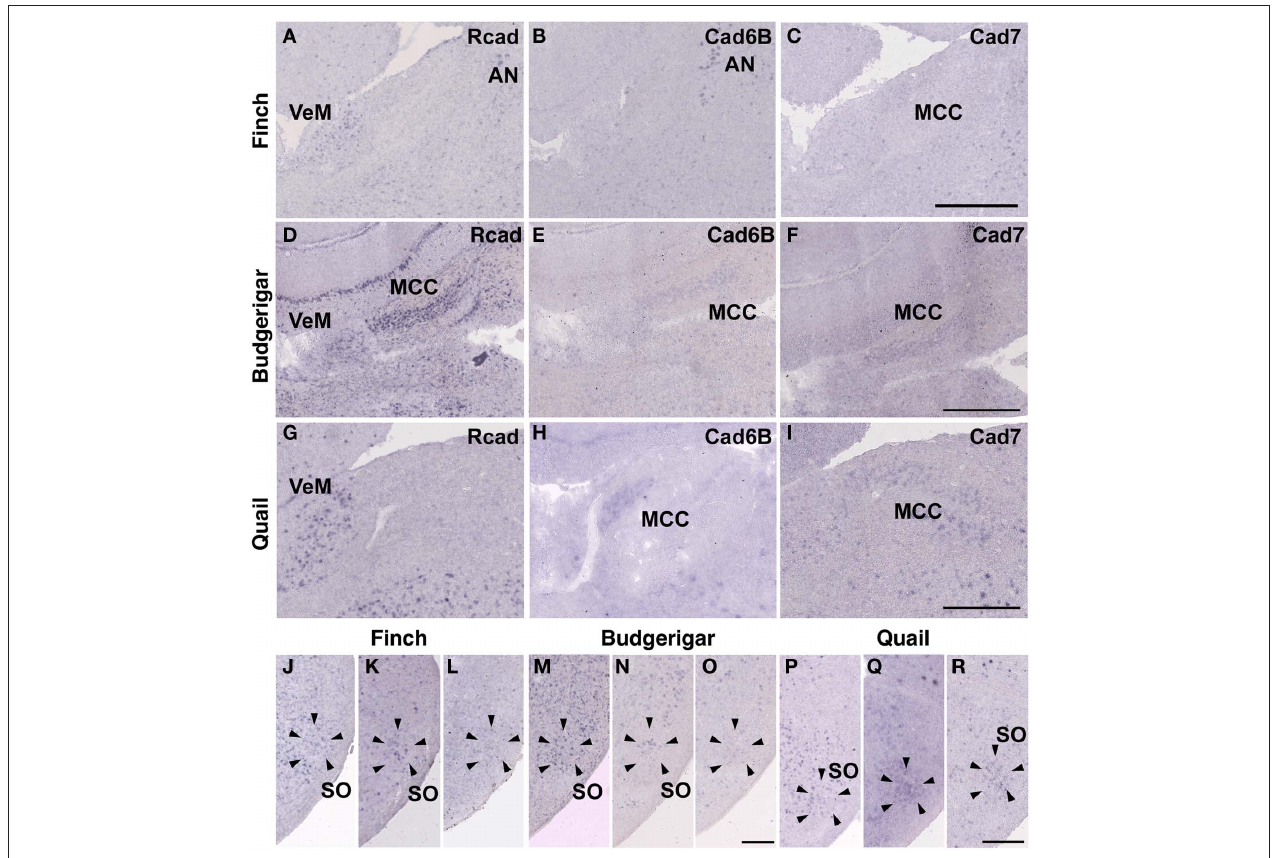
Figure 7 | Cadherin expression in the cochlear nucleus and superior olivary nucleus (SO) of the auditory system. (A–i) In situ hybridization for Rcad (A,D,g) , cad6B (B,e,H) , and cad7 (C,F,i) in the Bengalese finch (A–C) , budgerigar (D–F) , and quail (g–i) in the cochlear magnocellular nucleus (MCC). (J–r) In situ hybridization for Rcad (J,M,P) , cad6B (K,N,Q) , and cad7 (L,O,r) in the Bengalese finch (J–L) , budgerigar (M–O) , and quail (P–r) in the SO. Scale bars are 1 mm (C,F,i) and 500 μm (O,r)